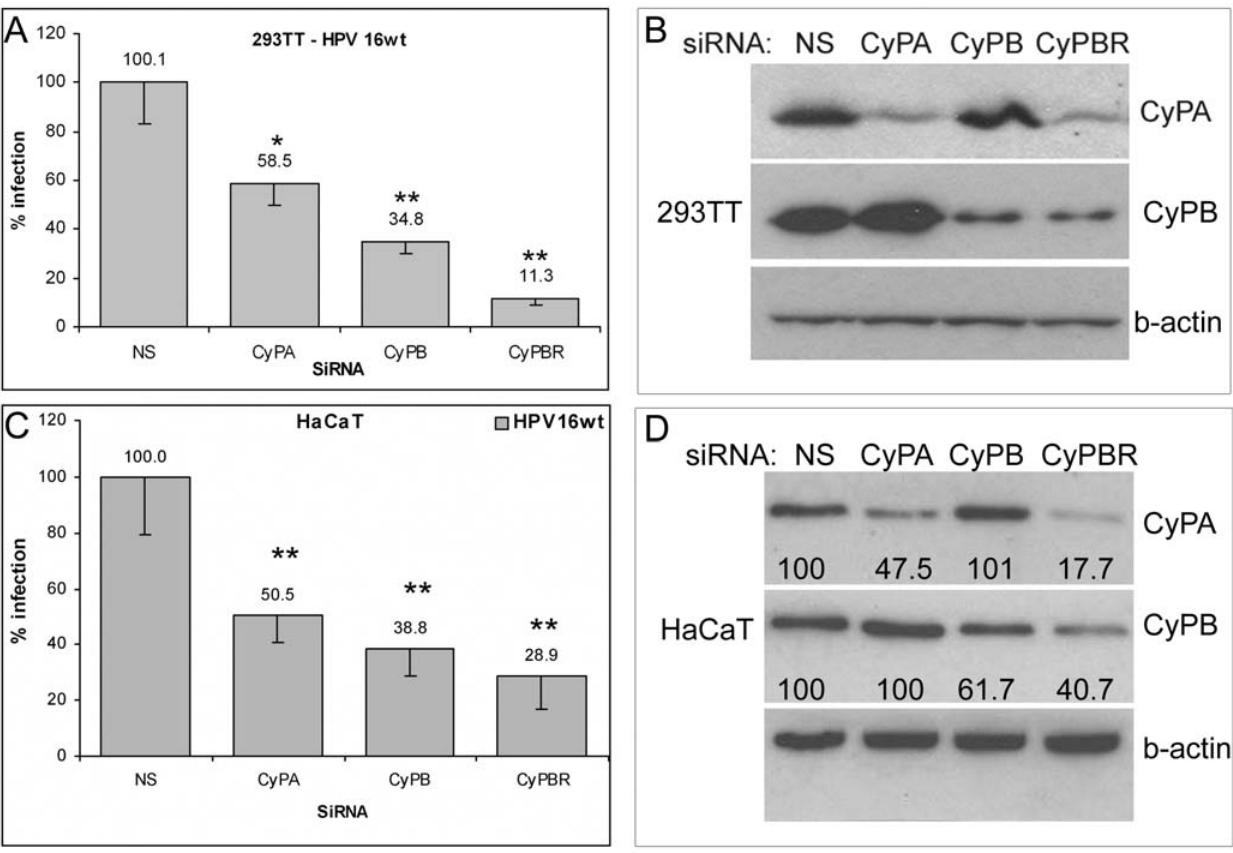
Figure 2. Knock down of CyP inhibits HPV16 infection. 293TT (A,B) or HaCaT (C,D) cells were transfected with indicated siRNA and infected with HPV16 pseudovirus 48h after transfection. Infection was scored at 72 hpi. Representative graphs based on six replicates are shown (A,C). Knockdown of CyPA and CyPB was confirmed by Western blot prior to infection (B,D). Numbers indicate percent levels of protein after correcting for input (D). *: p , 0.05; **: p , 0.01.